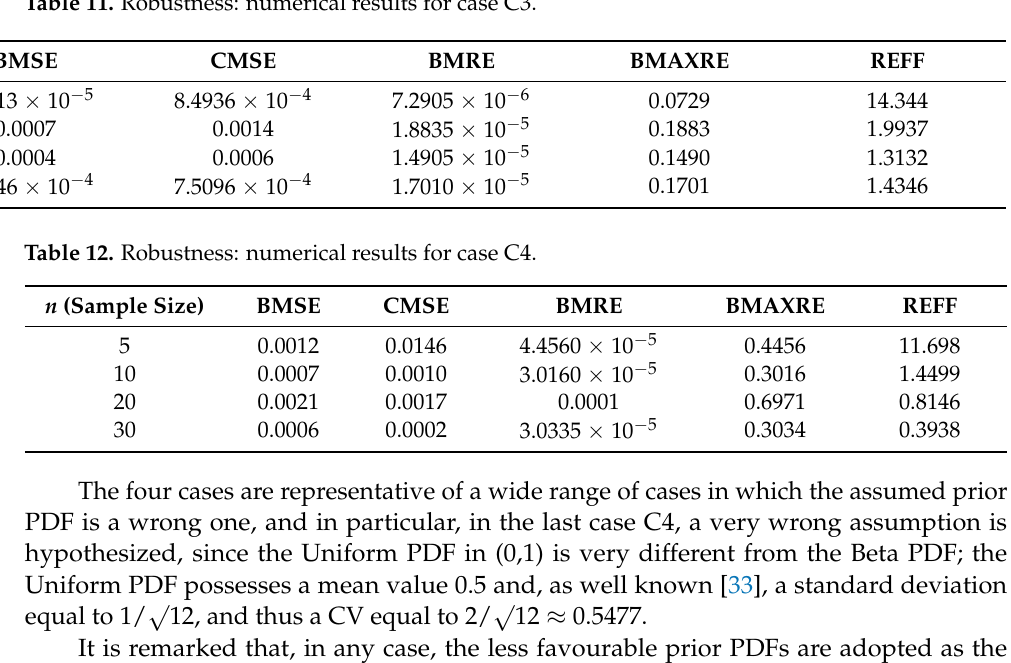
Table 11. Robustness: numerical results for case C3.